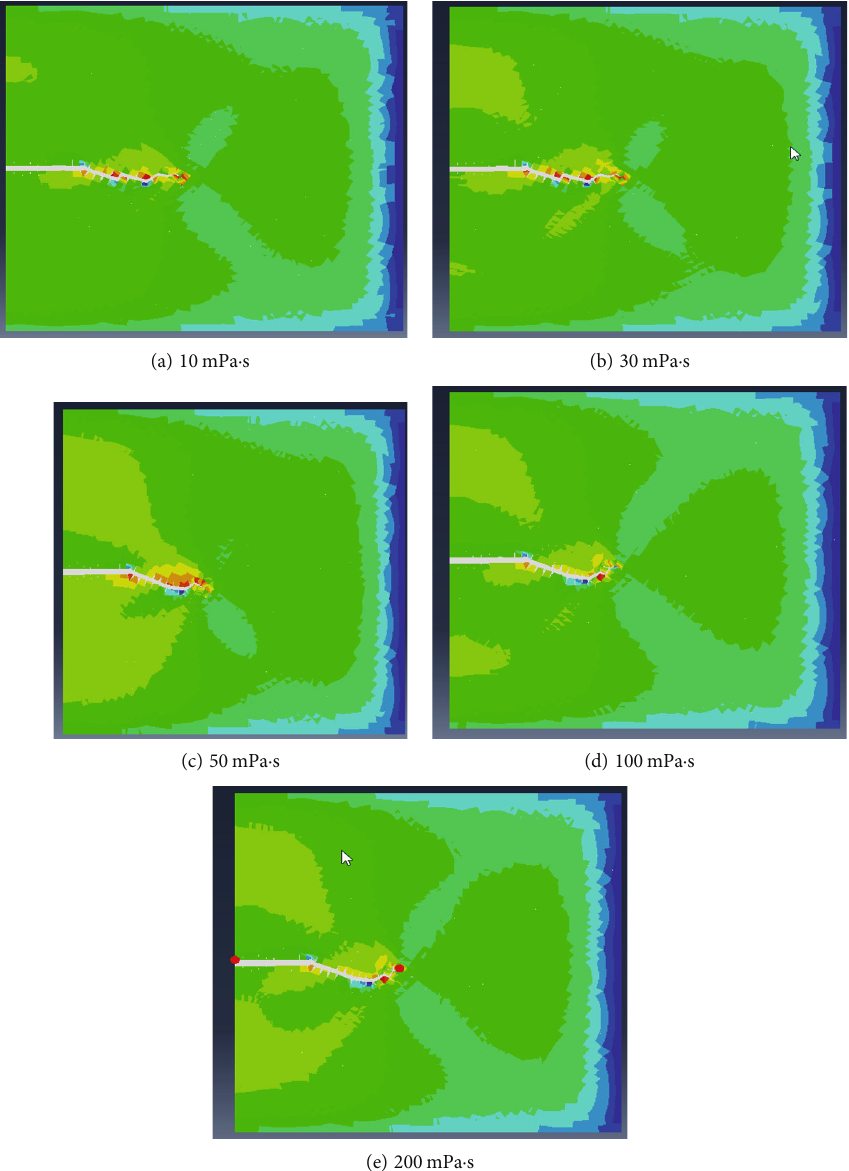
Figure 42: Stress contour map at the NF approaching angle of 60 ° and under the acid viscosity of 10-200mPa ·